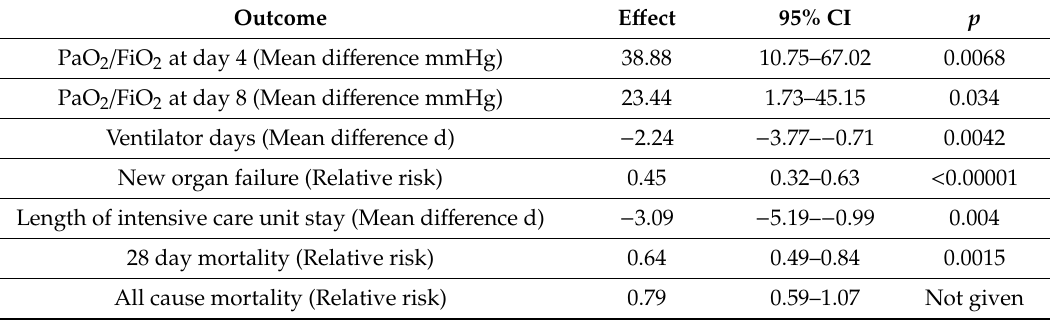
Table 1. Summary of the findings of the systematic review and meta-analysis of the e ff ects of n-3 fatty acid rich formulas in patients with acute respiratory distress syndrome